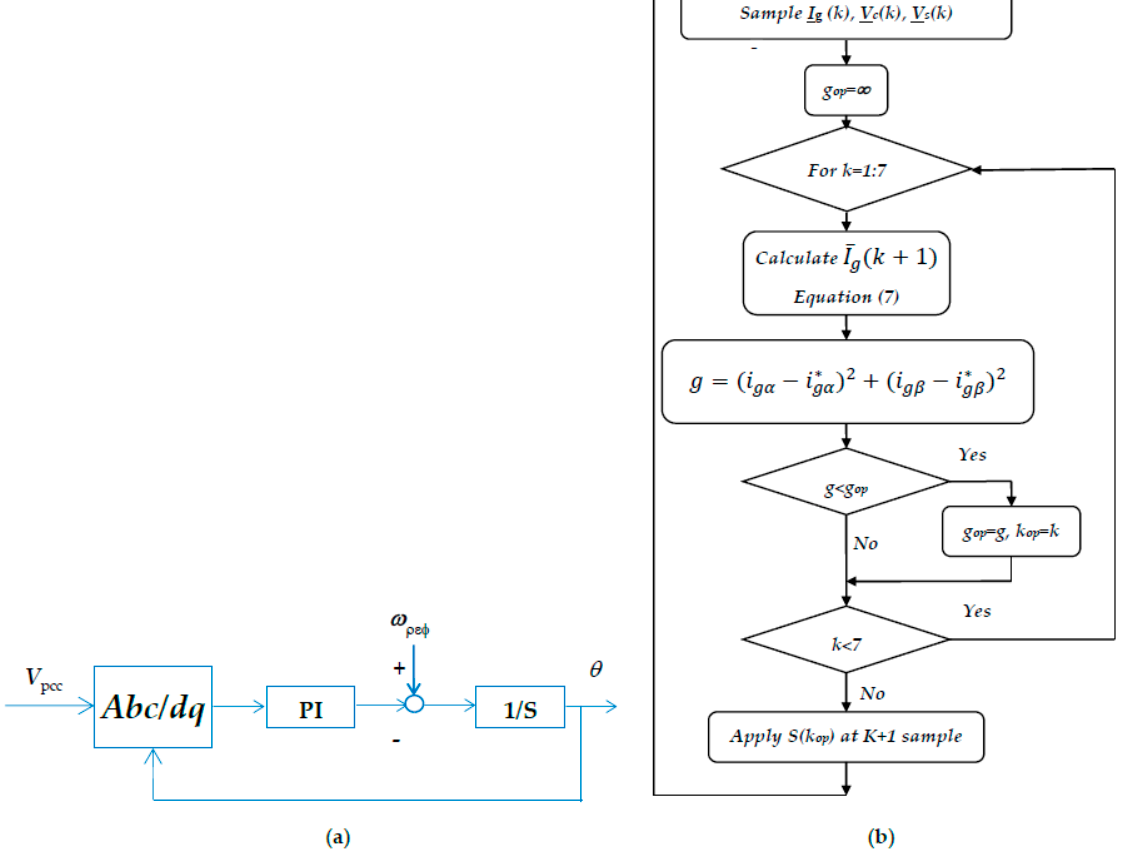
Figure 5. ( a ) The SRF PLL Block diagram. ( b ) The flowchart of the MPC algorithm for the pro- posed system.